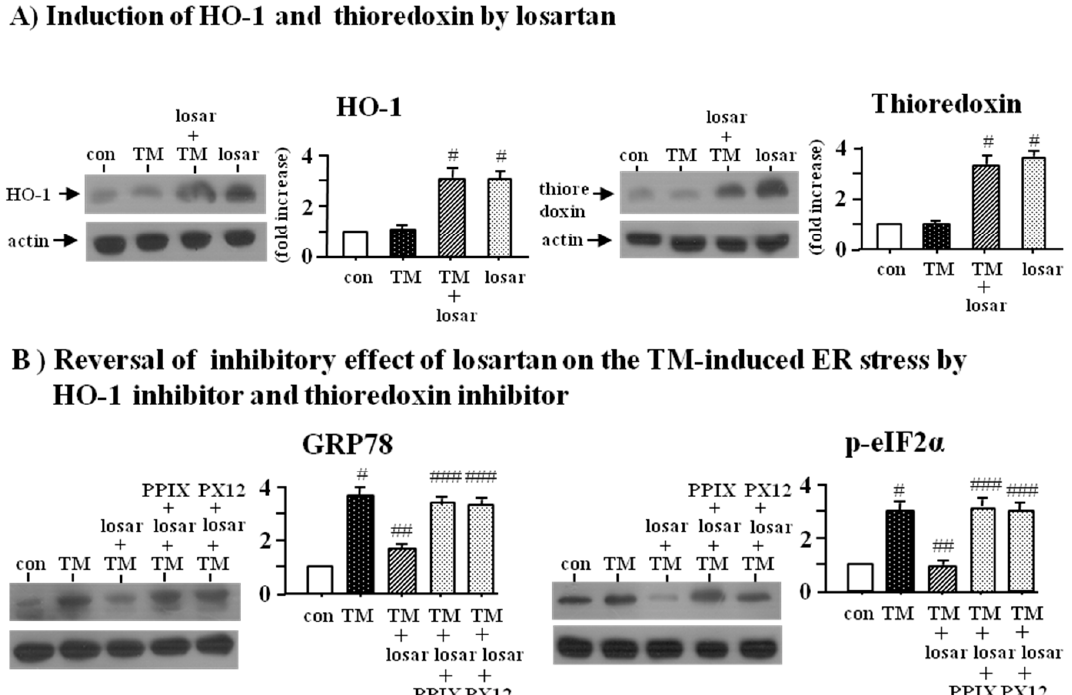
Figure 3. Induction of HO-1 (hemeoxygenase-1) and thioredoxin by losartan ( A ) and reversal of inhibitory effect of losartan on the tunicamycin-induced ER stress by HO-1 inhibitor (PPIX) and thioredoxin inhibitor (PX12) ( B ). Proximal tubular cells were incubated with tunicamycin (TM, 0.2 µM) with or without losartan (losar, 10 µM) for 24 h. Expression of heme oxygenase-1 (HO-1) and thioredoxin was examined by Western blot analysis ( A ). Proximal tubular cells were incubated with tunicamycin (TM, 0.2 µM) with or without losartan (losar, 10 µM), heme oxygenase-1 inhibitor (PPIX, 20 µM), and thioredoxin inhibitor (PX12, 25 µM) for 24 h. Expression of GRP78 and p-eIF2 α was examined by Western blot analysis ( B ). The relative densities of the bands for HO-1, thioredoxin, GRP78, and p-eIF2 α were normalized to those for actin for standardization. Representative blots and quantitative analysis from three independent experiments were shown. Results were expressed as n -fold increase over control as mean ± S.E. #: p < 0.05 vs. con (control); ##: p < 0.05 vs. TM; ###: p < 0.05 vs. TM + losar.